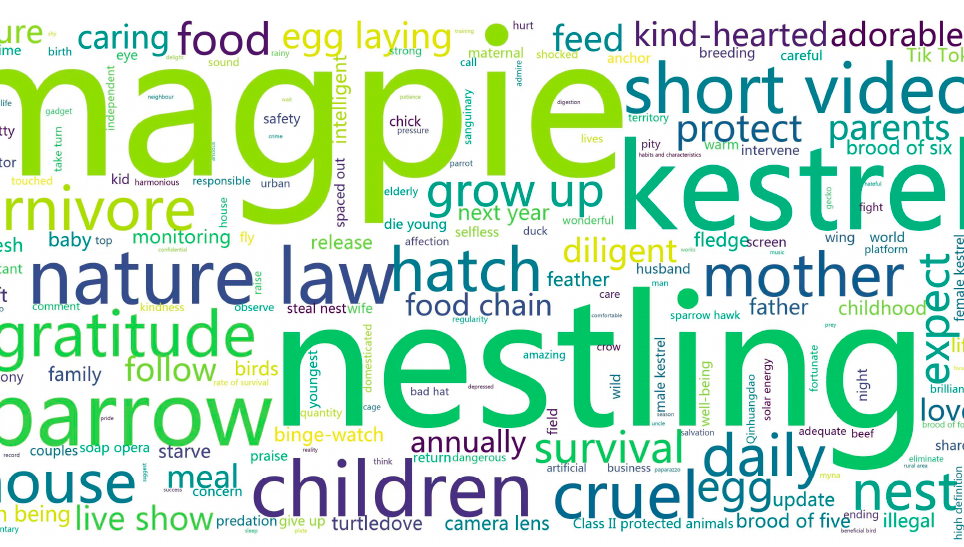
Figure 4. Perceptive word cloud